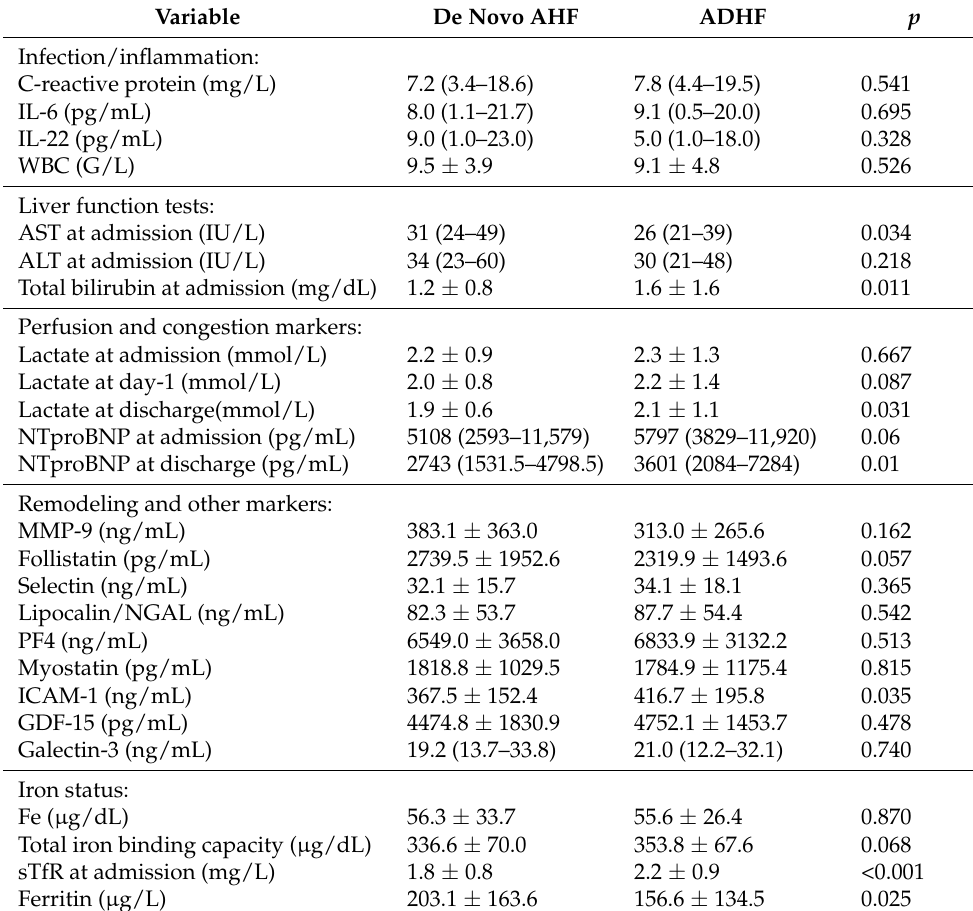
Table 3. Comparison of selected biomarkers of de novo AHF vs.